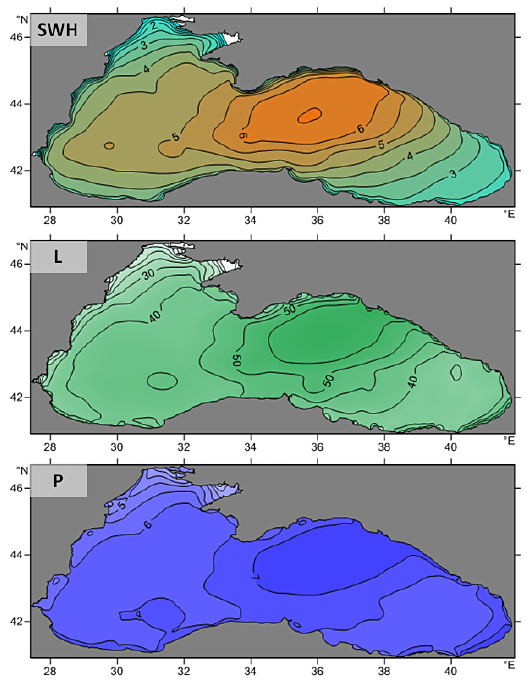
Figure 13. Maps of calculated significant wave height [m], wave length [m] and period [s] maxima in autumn.